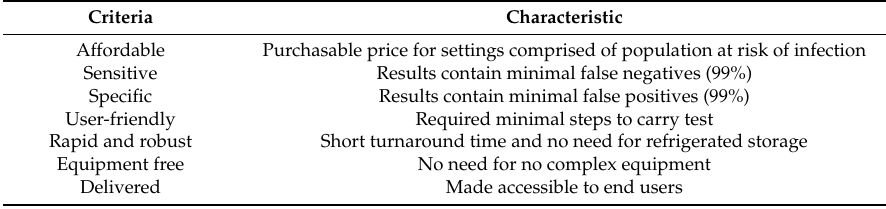
Table 1. The ASSURED (Affordability, Sensitivity, Specificity, User friendly, Rapid and robust, Equipment free and Delivered) criteria for ideal point-of-care (POC) diagnostics for use in resource-limited settings